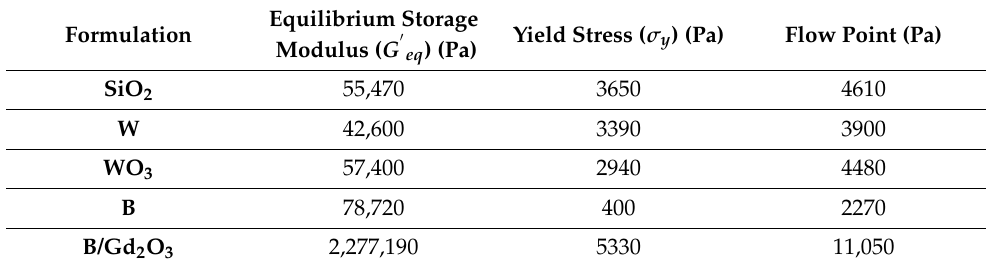
Figure 1. Rheological experiments showing ( a ) the storage modulus of the linear viscoelastic region and beginning of the nonlinear viscoelastic region of a representative sample of ink formulations, and ( b ) the loss and storage moduli of the W formulation until the flow point. Table 2. Rheological properties of a representative sample of ink formulations.